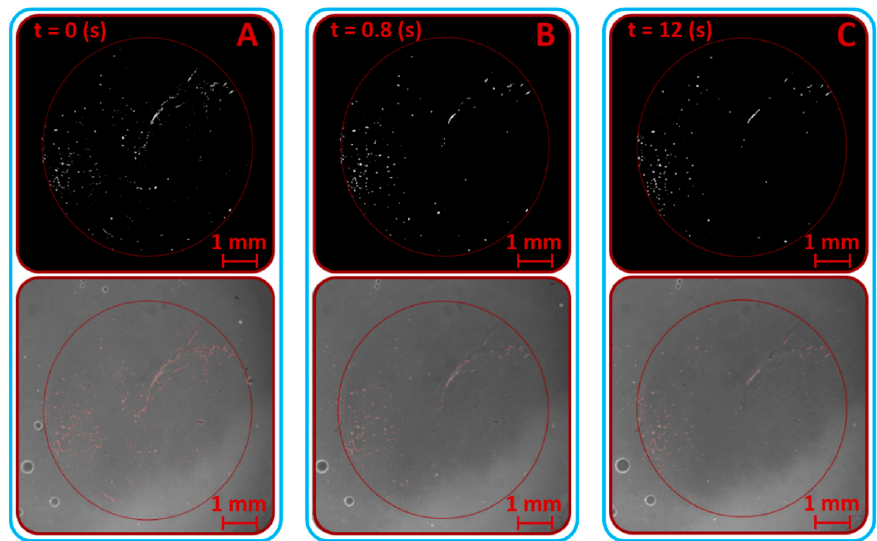
Figure 12. Loading of contact snaps – highlighted protein clusters by the software. ( A )—protein clusters at the beginning of the experiment (in the time 0 s), ( B )—protein clusters in the time 0.8 s, ( C )—protein clusters at the end of experiment (in the time 12 s).